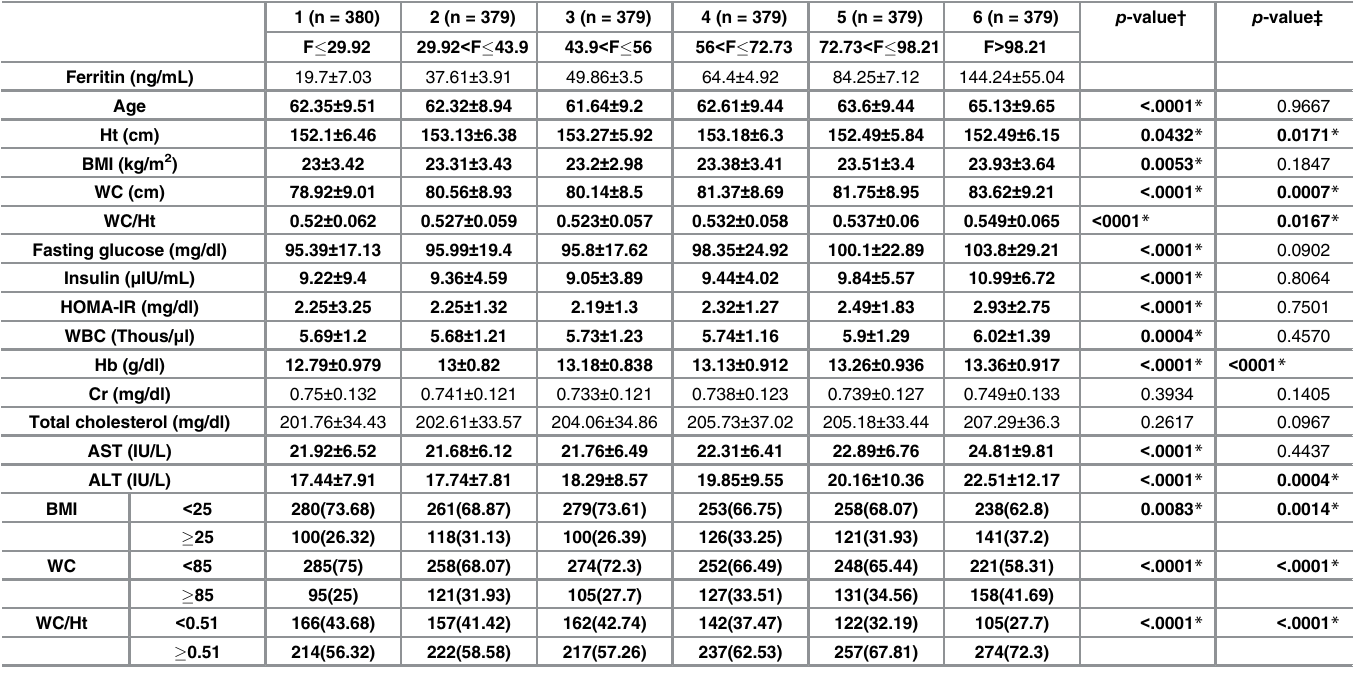
Table 2. Baseline characteristics of postmenopausal women according to serum ferritin